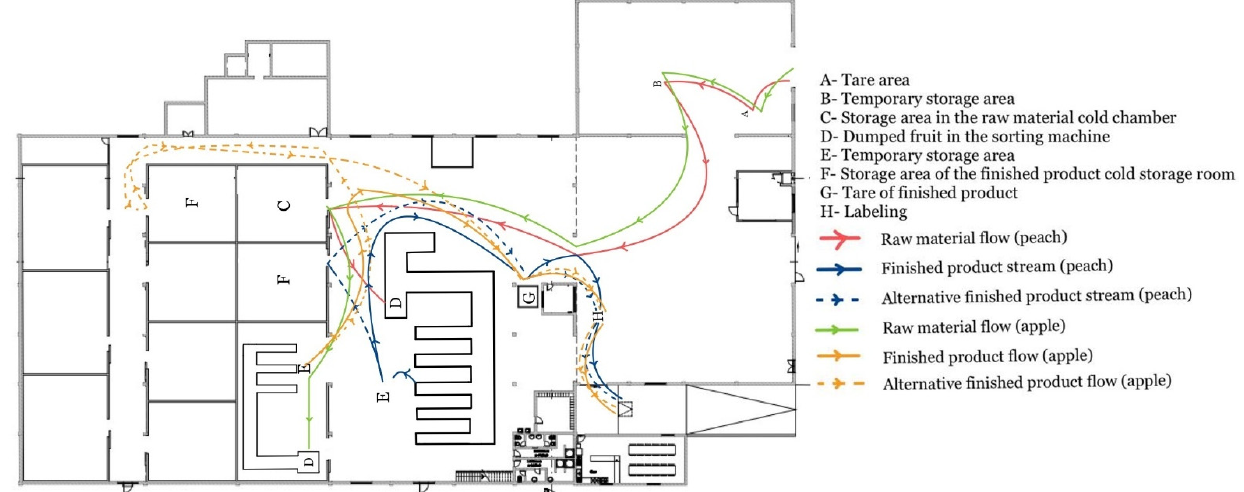
Figure 1. Spaghetti diagram of the production flow.